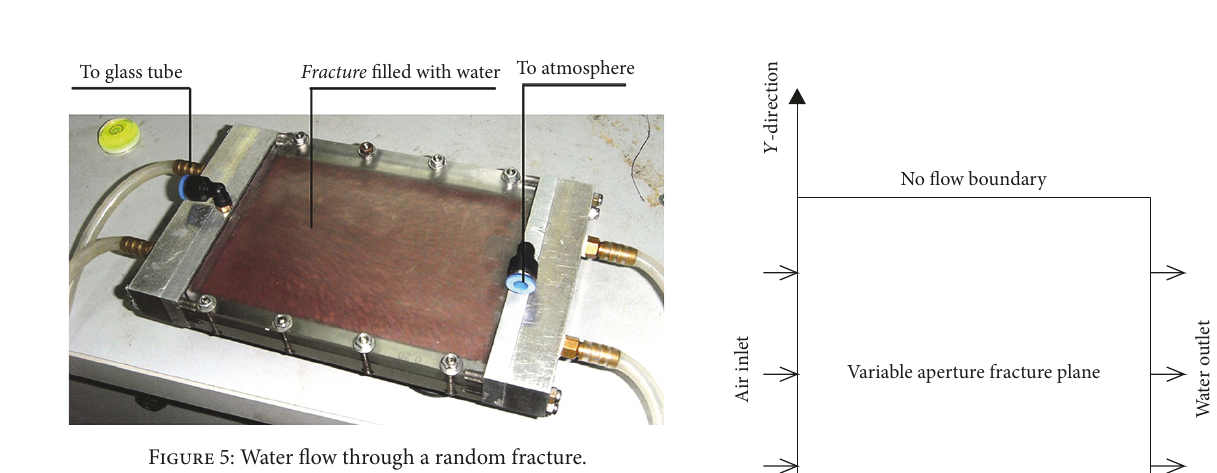
Figure 5: Water flow through a random fracture.